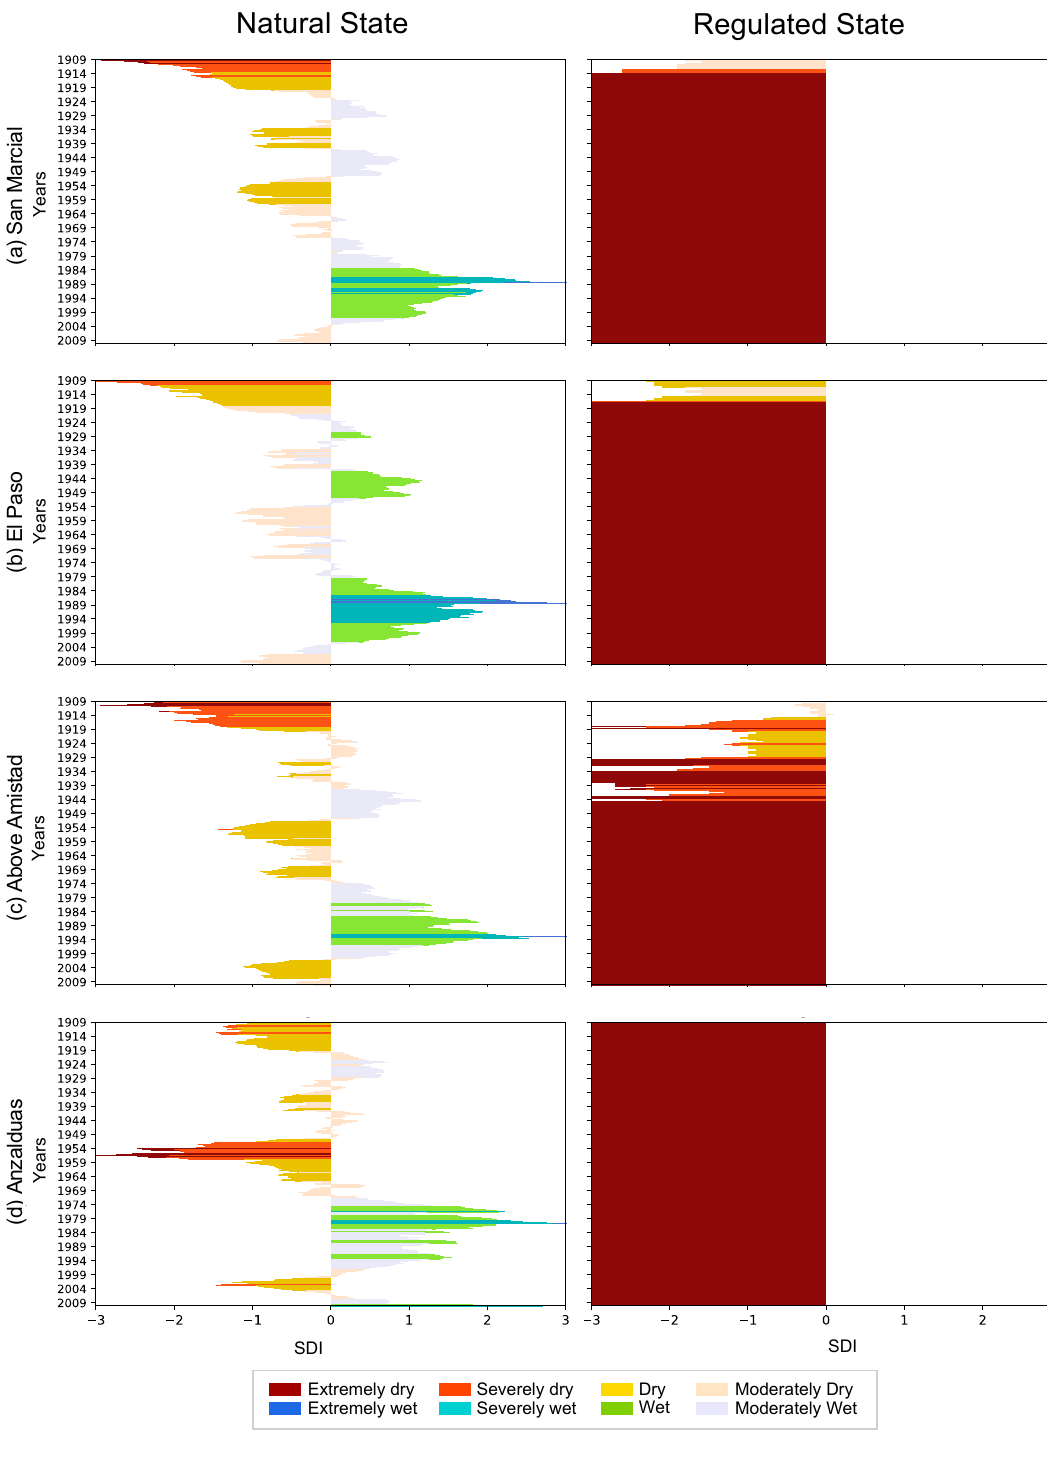
Figure 4. Streamflow drought index (SDI) indicating the hydrologic variability of the natural ( left ) and the regulated ( right ) state of four mainstem control points of the Rio Grande-Bravo Basin at ( a ) San Marcial, ( b ) El Paso, ( c ) Above Amistad, and ( d ) Anzalduas.